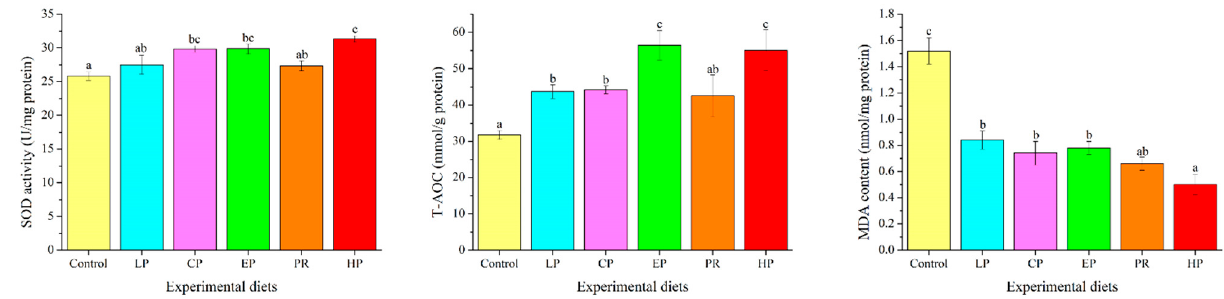
Figure 6. Effects of different diet treatments on antioxidant parameters in Oncorhynchus mykiss . Values are presented as mean ± SE, n = 12. The superscript letters indicate significant differences at p < 0.05.